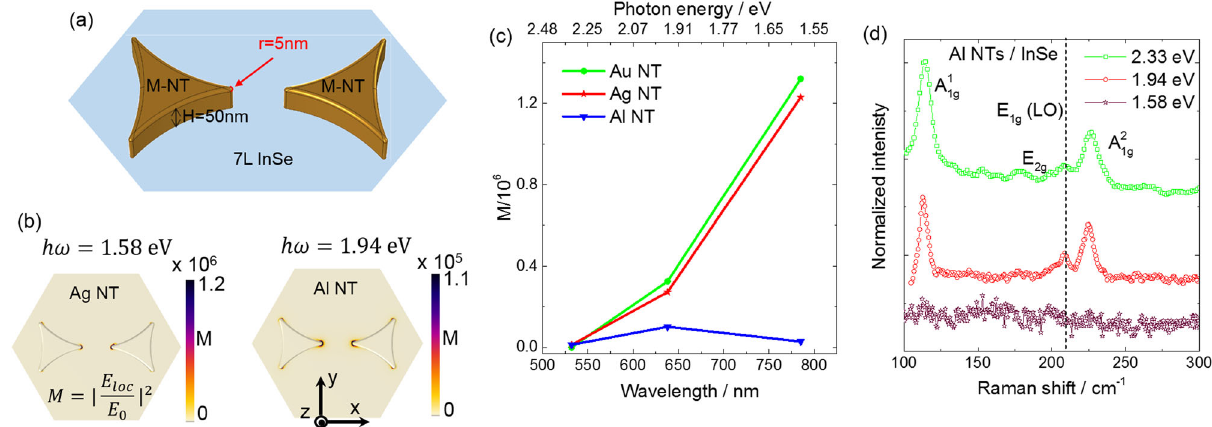
Fig. 2 Finite element method (FEM) simulation of plasmonic coupling between InSe and metal nanotriangles (NTs). a Sketch of the model used in the FEM simulation of InSe/metal NTs. b Simulated electric fi eld intensity M distribution at two different wavelengths for Ag and Al NTs. Simulated transmittance spectra of InSe/Ag, Au, and Al NTs systems for the spectral range from 380 to 1200 nm together with M distribution for Au NTs at 1.58 eV excitation are presented in Supplementary note 3. c Absolute value of calculated maximum M at three different excitations. A similar plasmonic behavior is expected for Ag and Au NTs on InSe for three selected wavelengths while InSe with Al NTs shows a maximum at 1.94 eV excitation. d Raman spectra of 7 L InSe with Al NTs acquired under three different wavelengths. As expected from simulations we can resolve the polar modes of InSe best at 1.94 eV excitation. Raman spectra of InSe with Au NTs are presented in Supplementary note